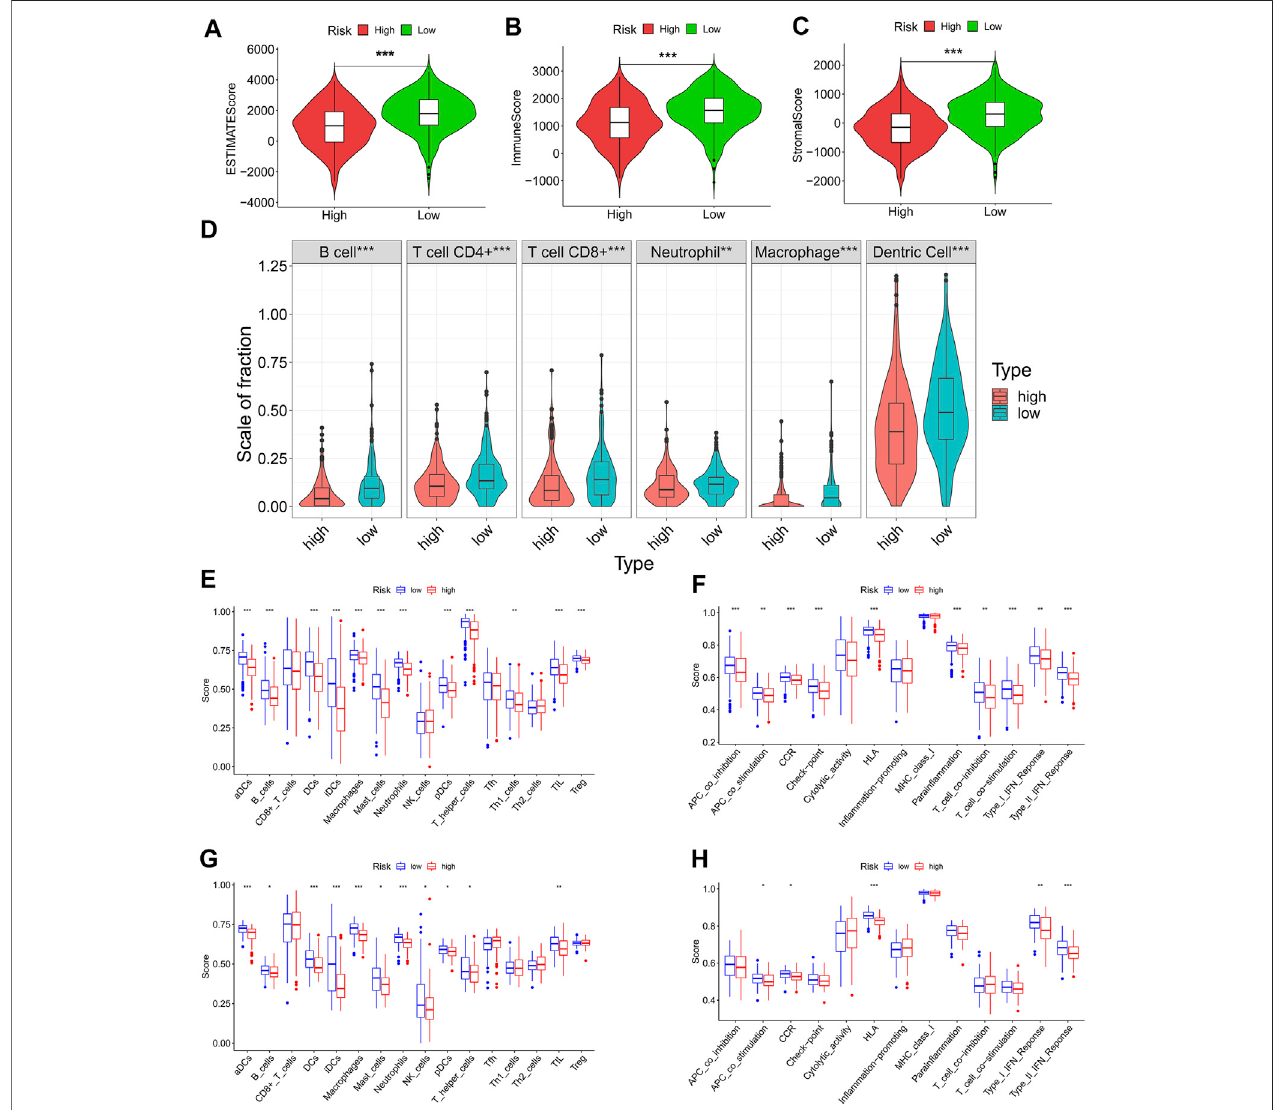
FIGURE 7 | Differences in immune cells and immune functions between the high- and low-risk groups (A-C) ESTIMATE score, immune score, and stromal score between the high- and low-risk groups (D) In fi ltration degree of immune cells between the high- and low-risk groups in TCGA cohort based on TIMER (E) Fraction of immune cells between the high- and low-risk groups based on ssGSEA in the TCGA cohort (F) Immune functions between the high- and low-risk groups based on ssGSEA in the TCGA cohort (G) Fraction of immune cells between the high- and low-risk groups based on ssGSEA in the GEO cohort (H) Immune functions between the high- and low-risk groups based on ssGSEA in the GEO cohort. TCGA = The Cancer Genome Atlas; GEO = Gene Expression Omnibus; * p < 0.05; ** p < 0.01; *** p < 0.001.